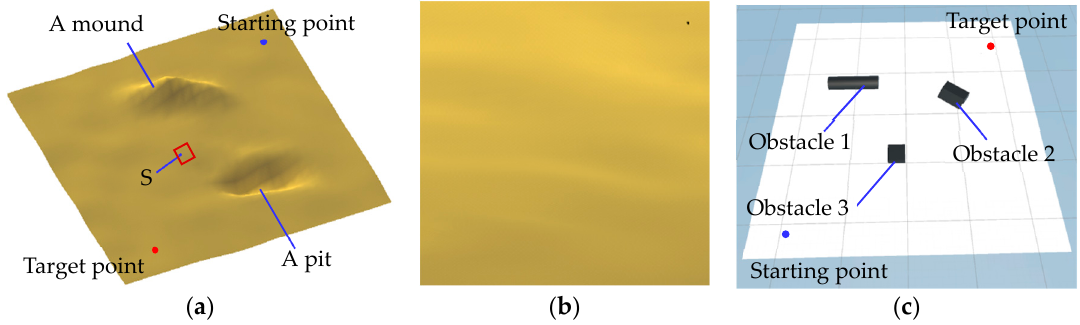
Figure 10. Simulation environments for the robot: ( a ) stochastic ground with a pit and a mound; ( b ) an enlarged view of the area S of the stochastic ground; ( c ) a planar ground with three obstacles.